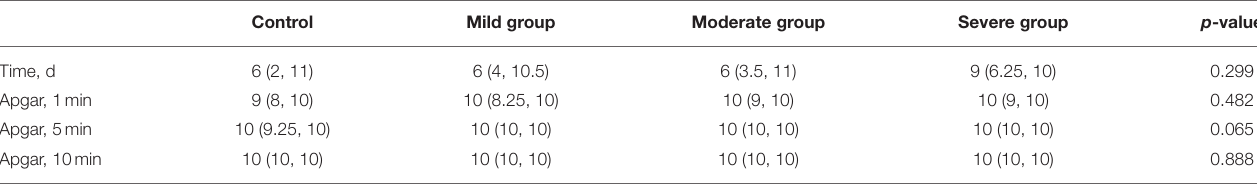
TABLE 1 | Characteristics of participants.